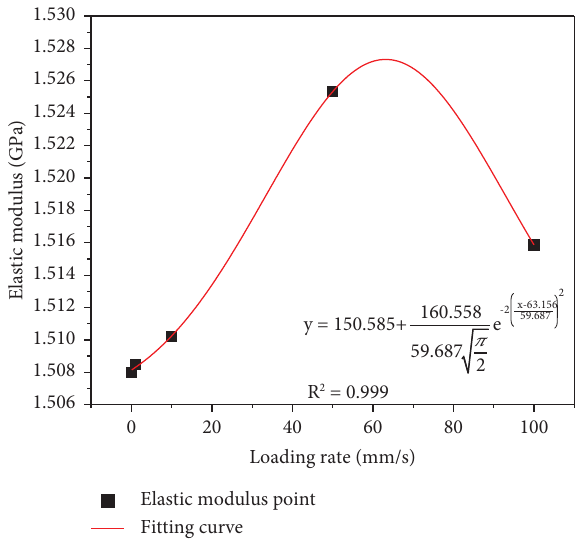
Figure 8: Curve of the cracking stress